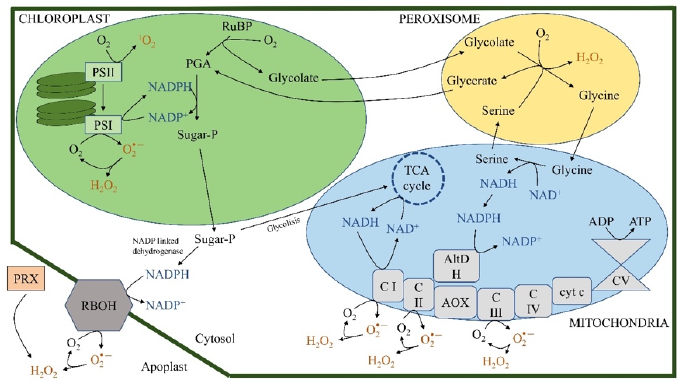
Figure 3. Most important sources of ROS in plant cells. Singlet oxygen ( 1 O 2 ) may originate from excited triplet chlorophylls (Chl) that activate ground-state O 2 in the photosystem II (PSII) reaction center. In PSI, superoxide and hydrogen peroxide can be produced by reducing O 2 . In the mito- chondrial electron transport chain, complexes CI, CII, and CIII are ROS-generating systems. AltDH, alternative dehydrogenase; AOX, alternative oxidase; cyt. c, cytochrome c; CI-V, mitochondrial complex I–V; PGA, phosphoglycerate; PS, photosystem; PRX, peroxidase; RBOH, respiratory burst oxidase homologs; RuBP, ribulose 1,5-bisphosphate; Sugar-P, sugar–phosphate; TCA, tricarboxylic acid. Modified from